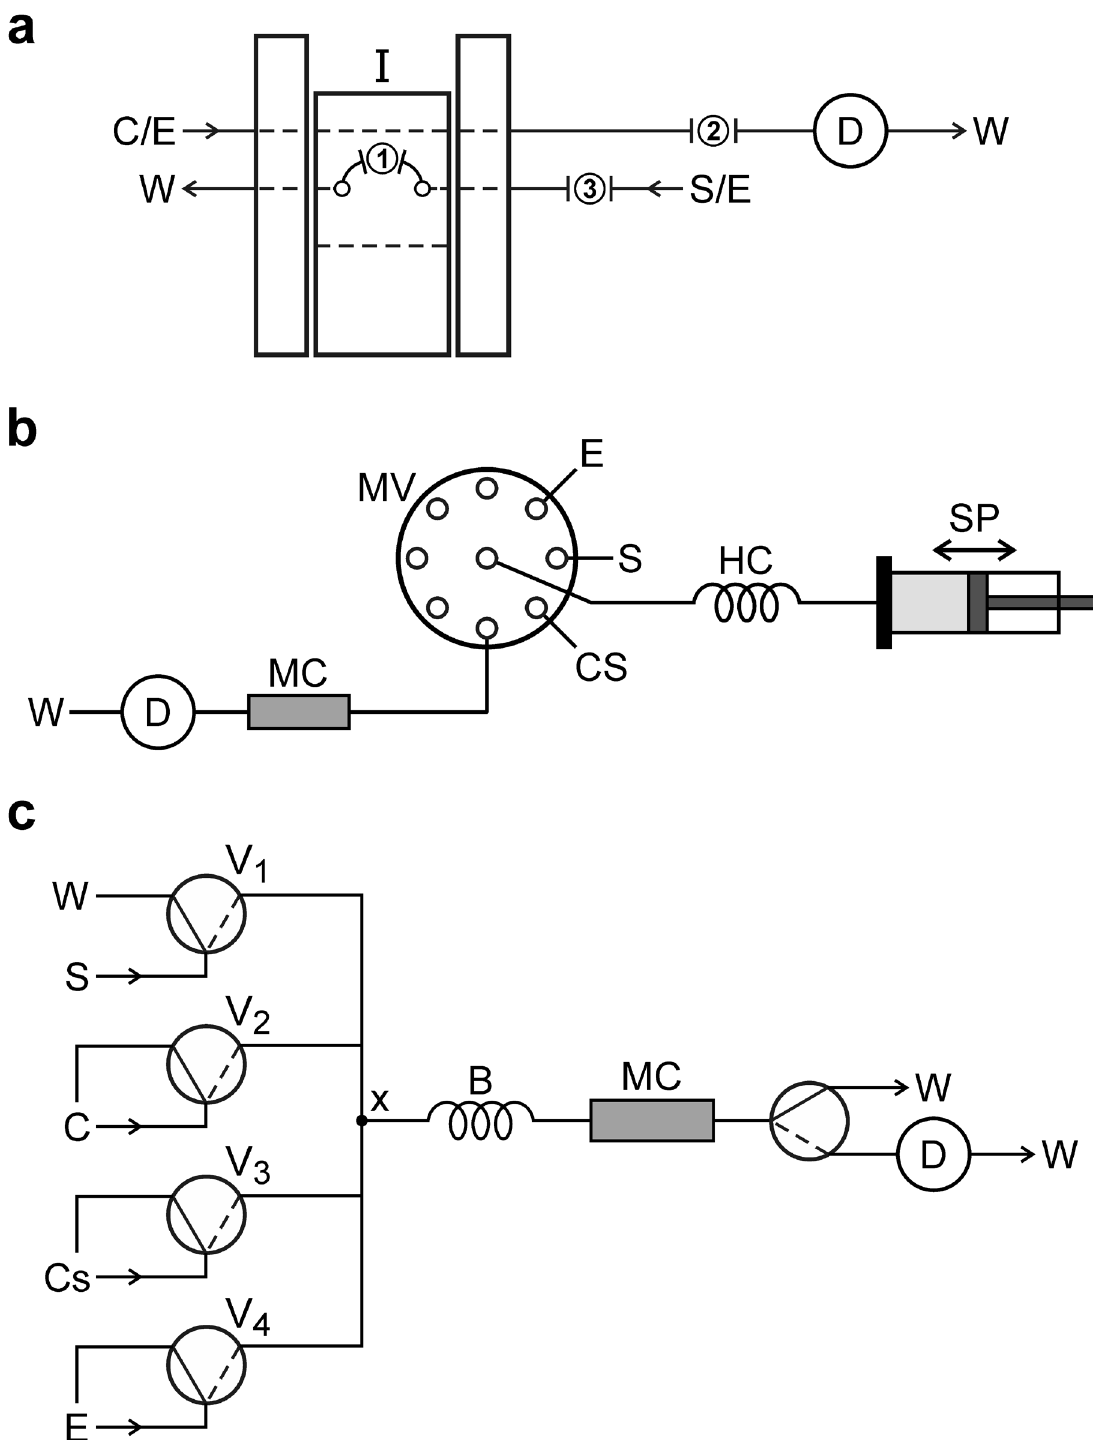
Figure 1 - Flow diagrams of analytical systems with SPE mini-columns (MC): ( a ) FIA with a sliding bar injector (I). MC placed in positions 1, 2 or 3; ( b ) SIA and ( c ) MCFA; S: sample; B: mixing coil; C: carrier stream; CS: conditioning solution; D: detector; E: eluent; HC: holding coil; MV: multi-position valve; SP: syringe pump; Vi: solenoid valves; x: confluence joint point; W: waste recovery